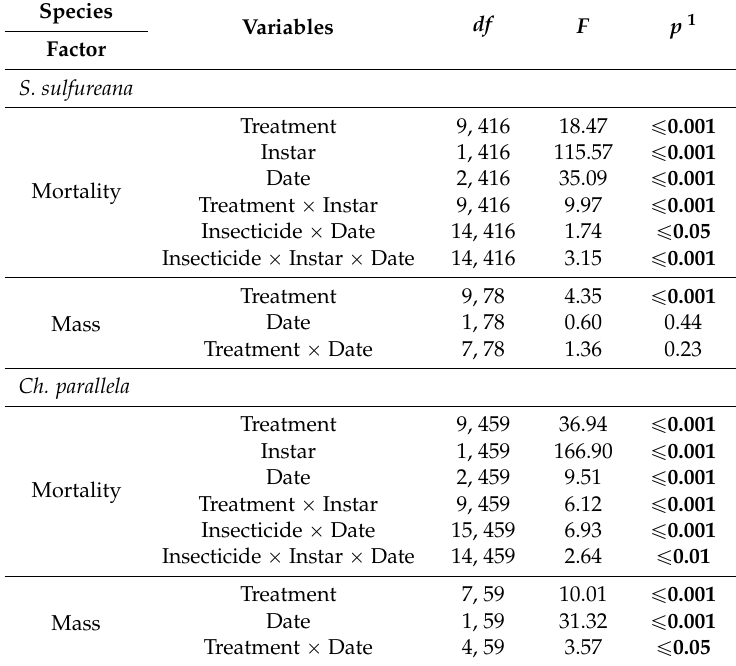
Table 3. Results from analysis of variance (ANOVA) for extended laboratory studies on the effects of insecticides, days after treatment, instar, and their interactions on Sparganothis sulfureana and Choristoneura parallela percent larval mortality and mass of surviving 3rd instar larvae.